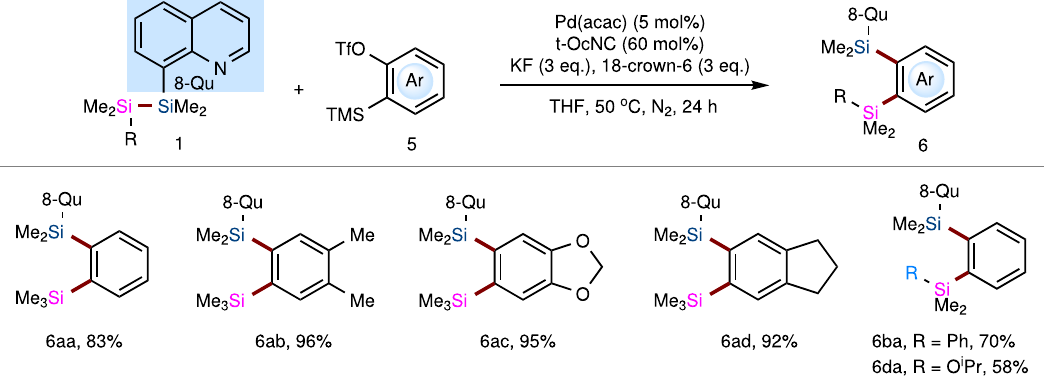
Fig. 4 The bis-silylation reaction of TMDQ reagent 1 with aryne 5. Standard reaction conditions: TMDQ reagent 1 (0.2 mmol), aryne precursor 5 (0.4 mmol), Pd(acac) 2 (3 mg, 0.01 mmol), t -OcNC (17 mg, 0.12 mmol), KF (35 mg, 0.6 mmol), and 18-crown-6 (159 mg, 0.6 mmol) in THF (2 mL) at 50 °C under N 2 atmosphere for 24 h. See Supplementary Information (SI) for